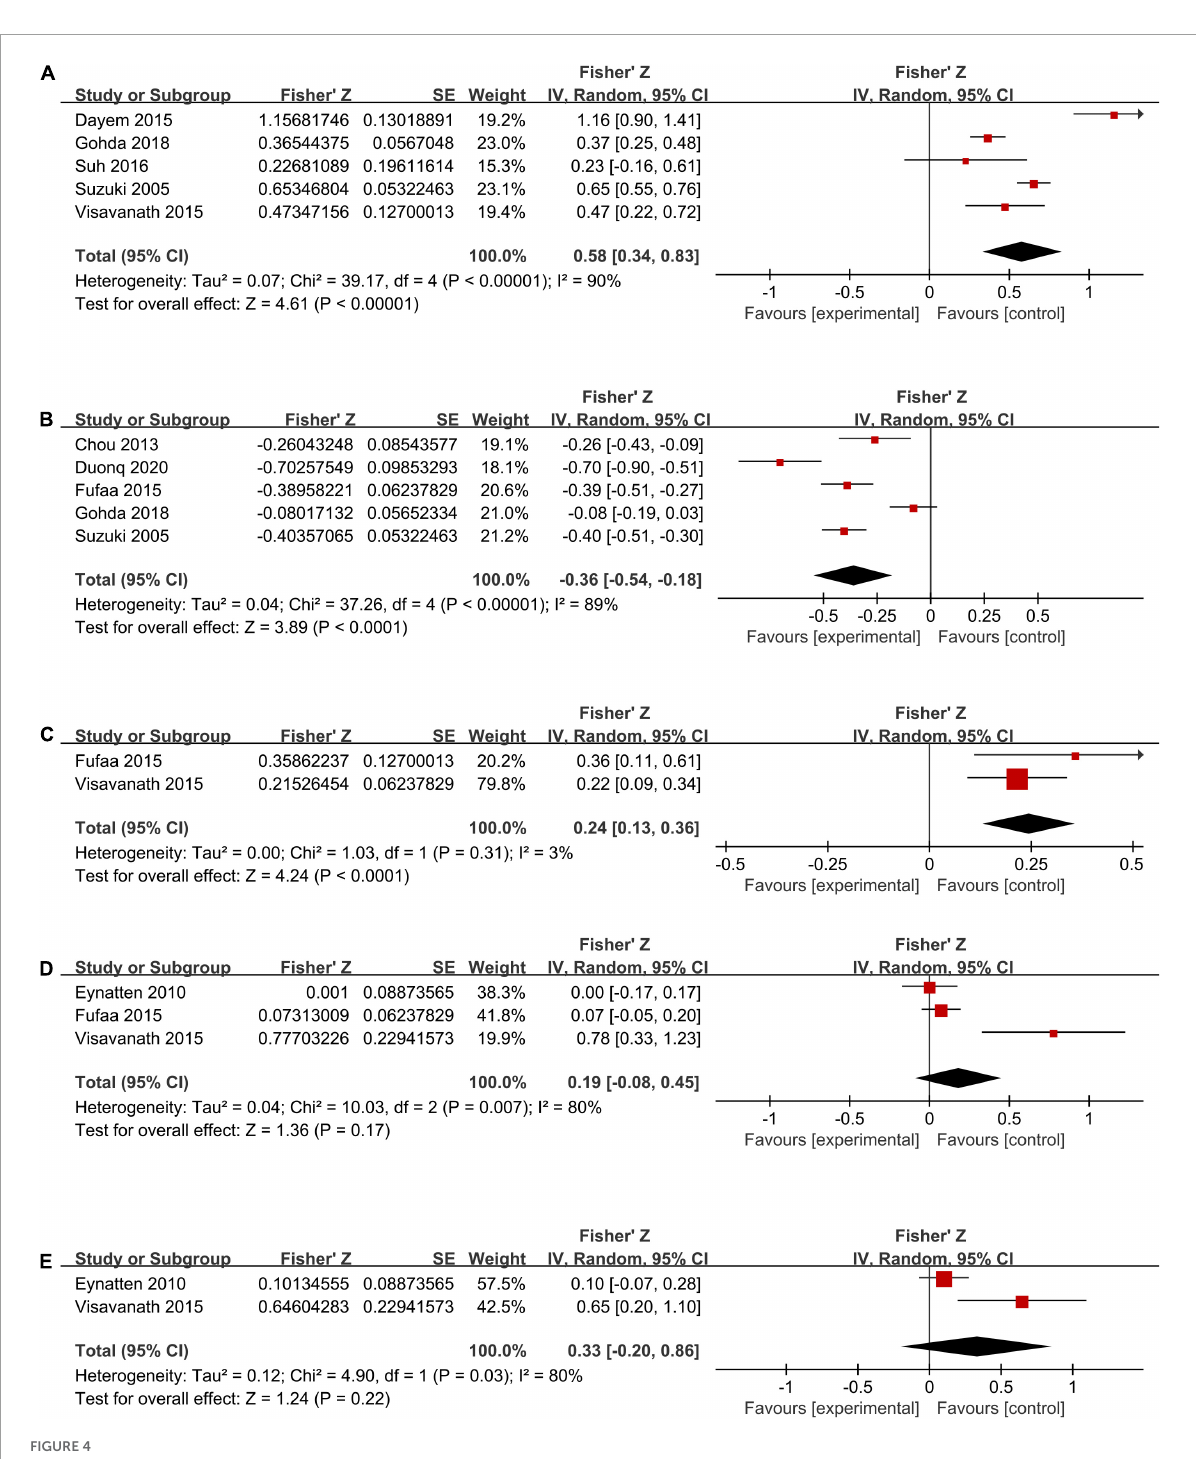
damage occurred prior to the glomerular injury in subjects with DM (35). Thus, uL-FABP may be an earlier indicator than ACR or urinary albumin in the detection of renal injury in subjects with DM (6). Furthermore, > 30% of diabetic